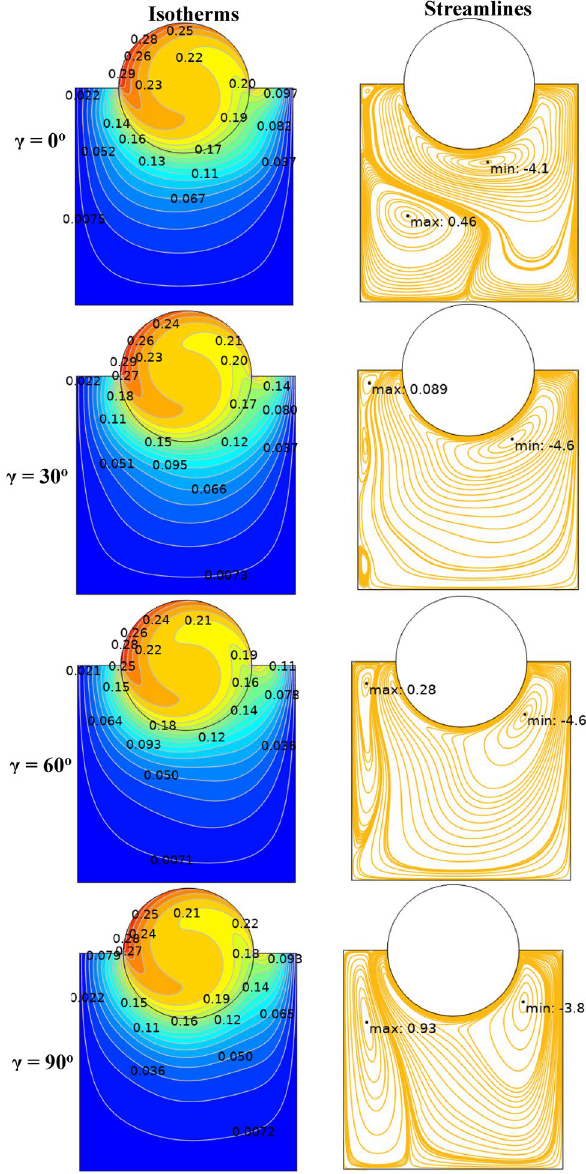
Figure 9. Isotherms and streamlines contours for different inclination angles, with Ra = 10 6 , Ha = 60, K = 1, Ω = 500, and λ = 0.52.